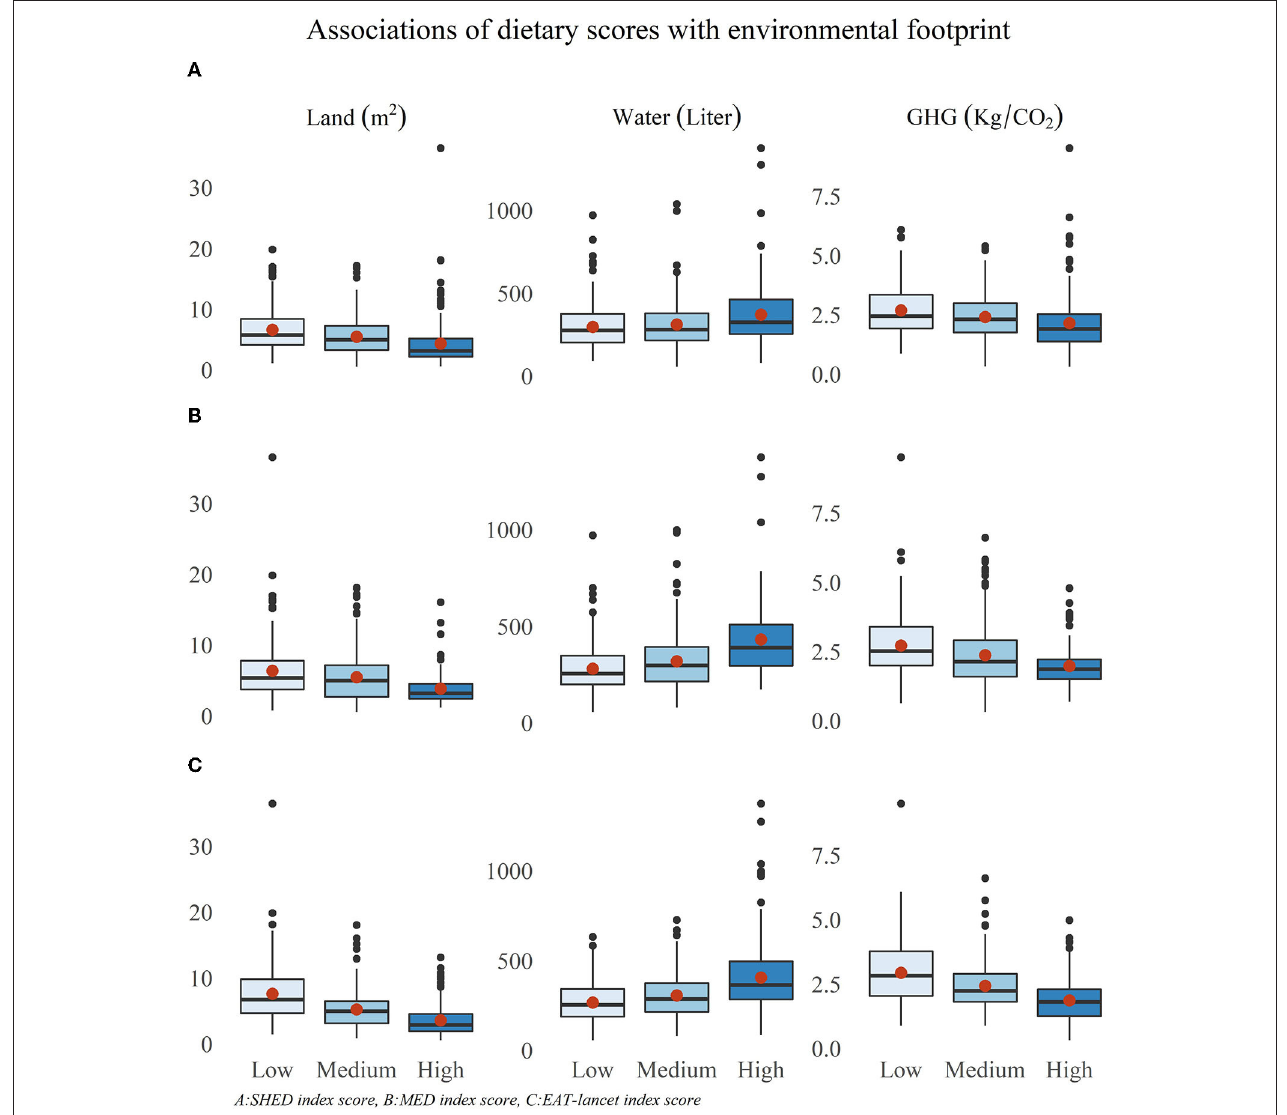
FIGURE 2 | Environmental footprint of different dietary patterns. *All P < 0.0001 (Kruskal-Wallis